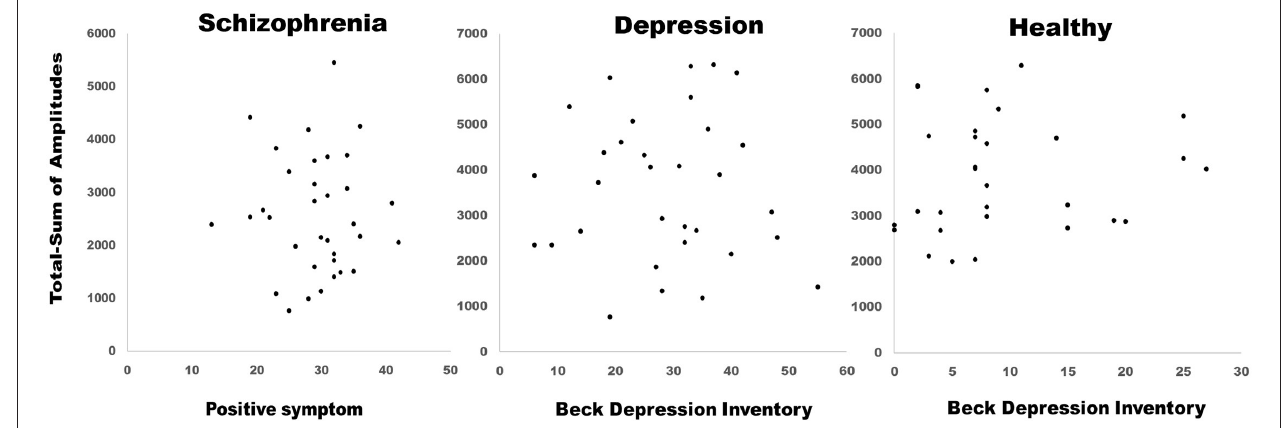
FIGURE 3 | Correlations between clinical symptoms and AP300. Correlations were not significant.